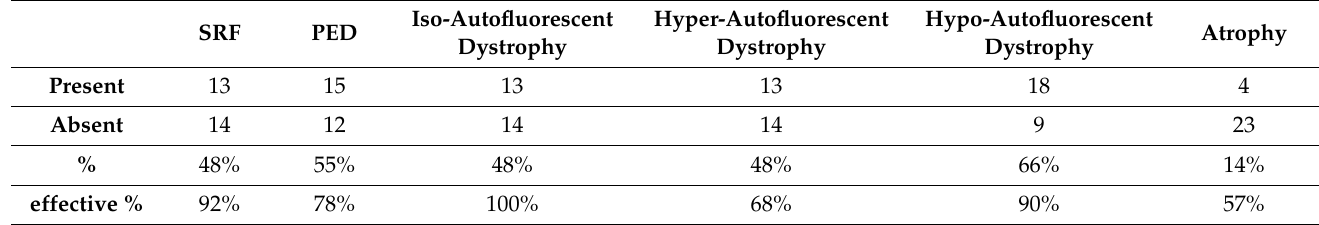
Table 3. Summary of outer retinal features detected by scanning laser ophthalmoscopy (SLO) retromode imaging for the characterization of our study population. Percentage (%) is described as the ratio between the number of eyes in which the feature was detected over the total number of eyes examined. Effective % describes the ratio between the number of eyes in which SLO retromode was able to identify the feature and the number of eyes in which multimodal imaging could detect the feature, thus the % of accordance between FAF and multimodal imaging accuracy in identifying the